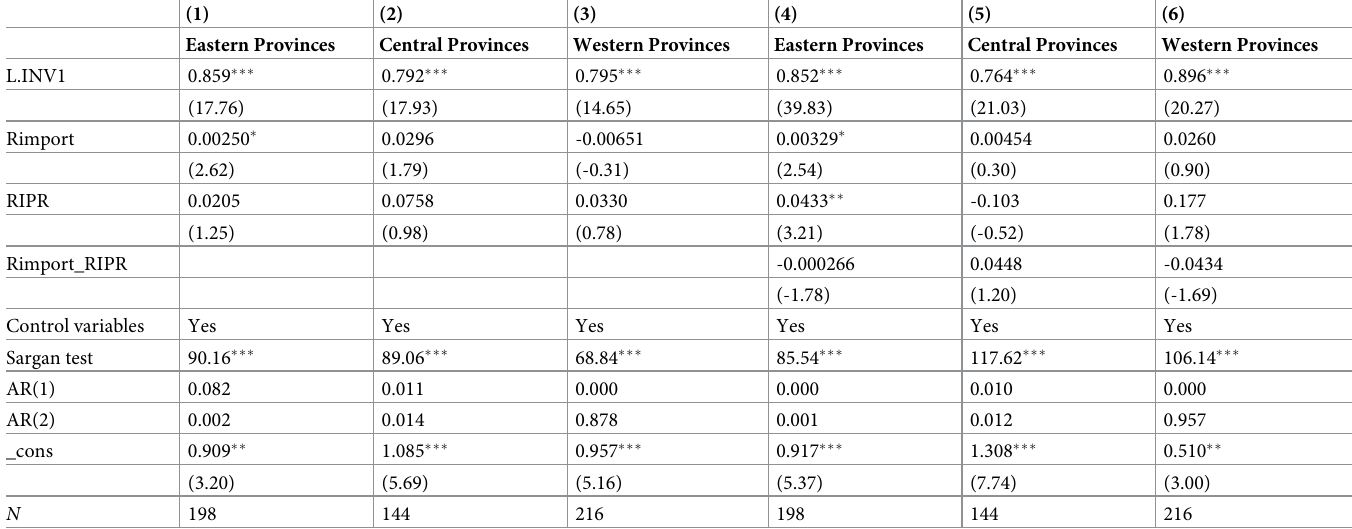
Table 9. System GMM estimates by region ( Rimport